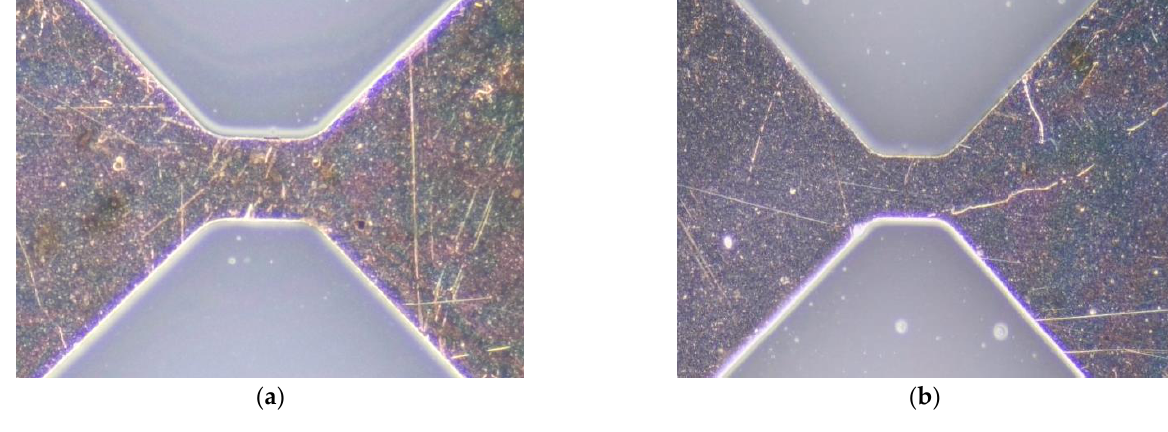
Figure 1. Cu explosive bridge film with hole ( a ) and scratch ( b ).